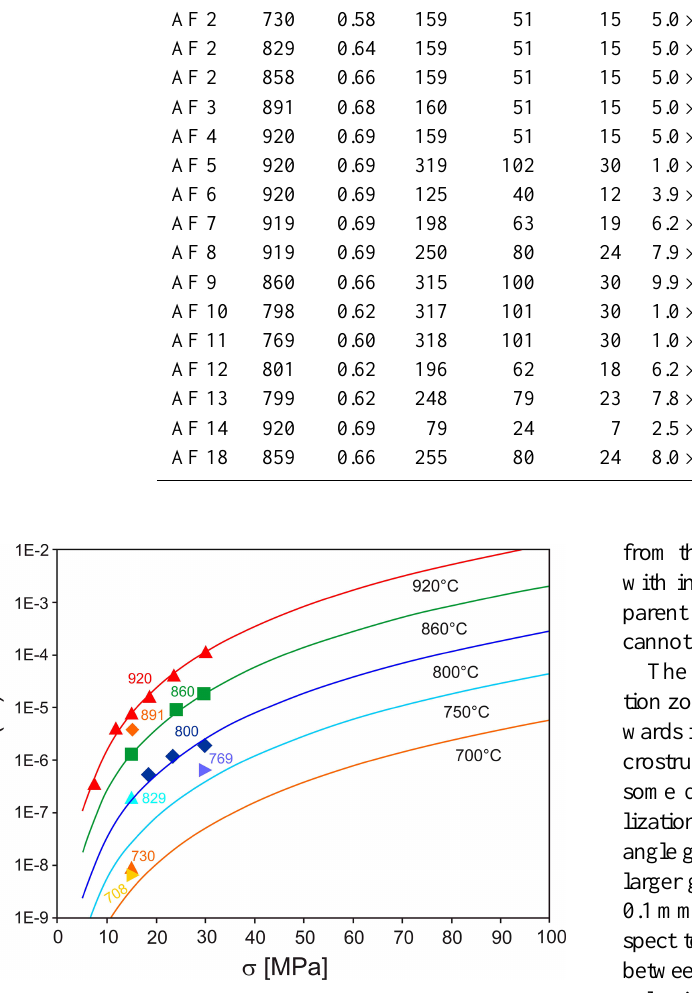
Figure 8. Experimental data obtained at various temperatures be- tween 700 to 920 ◦ C and adapted flow law displayed as reference strain rate as a function of reference